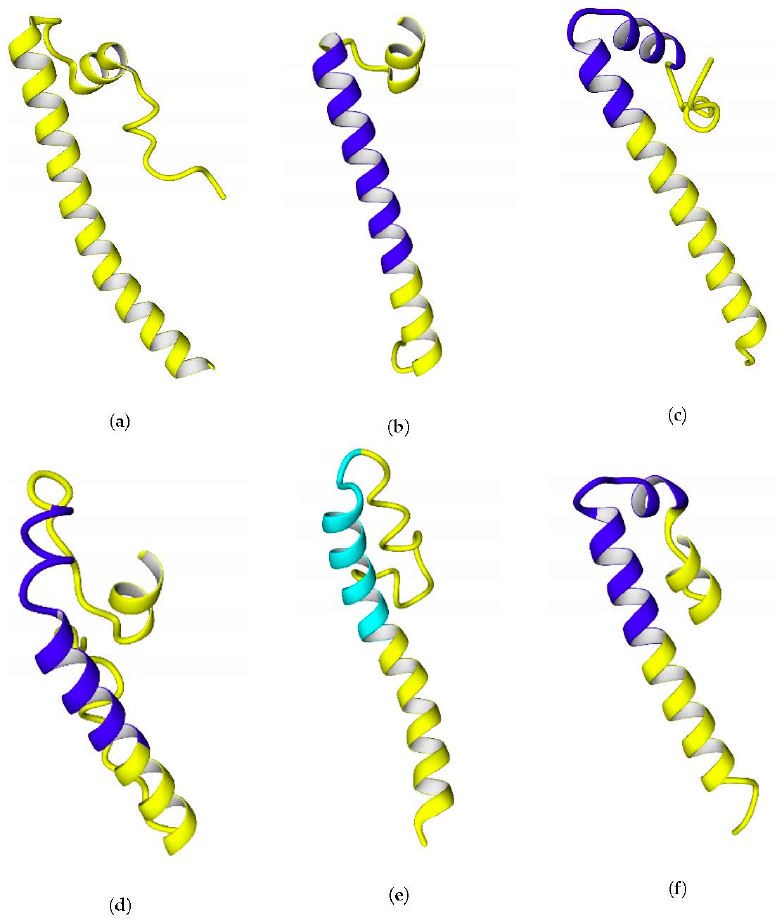
Figure 7. C-terminal parts of the small subunits of the hydrogenases (extracted from final full-size models, see below). Regions corresponding to predicted transmembrane helices are colored blue. The corresponding region of HupSL from Rvi. gelatinosus is colored cyan. The C-termini of the helices are positioned at the bottom of each figure. The panels of the figure correspond to the following enzymes: ( a ) HupS from Tca. roseopersicina ; ( b ) HupS from Rba. capsulatus ; ( c ) HupS from Rba. sphaeroides ; ( d ) HupS from Rps. palustris ; ( e ) HupS from Rvi. gelatinosus ; and ( f ) HupS from Rsp. rubrum .